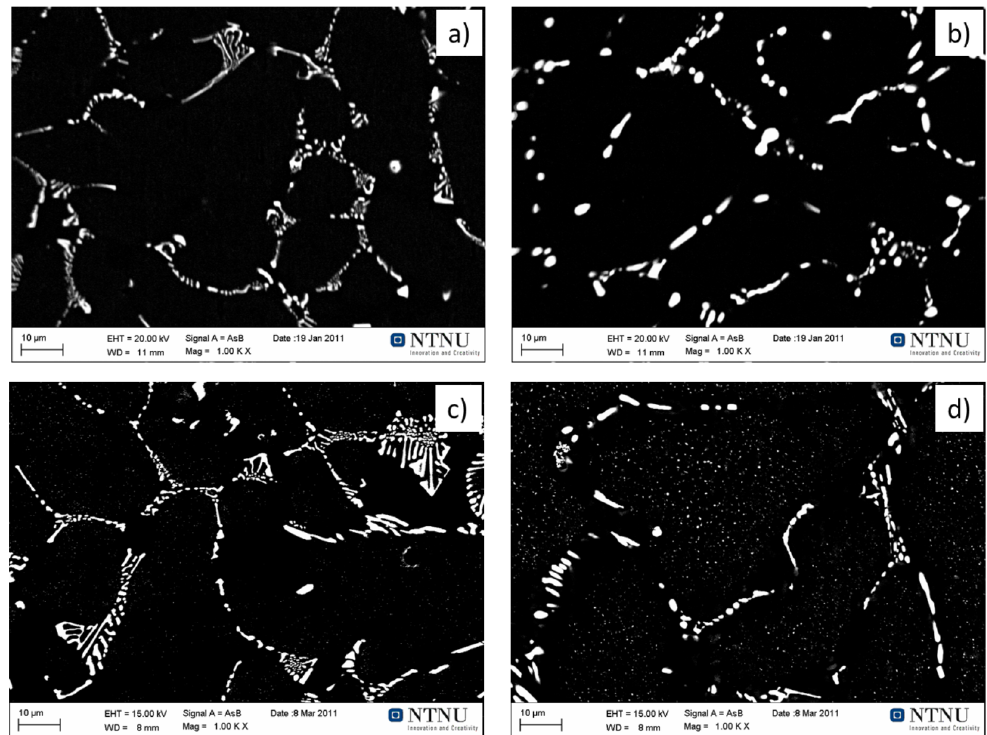
Figure 1. Back scatter electron scanning electron microscopy (SEM) images of constituent particles after the different homogenization procedures: ( a ) C2 ‐ 0 (non ‐ homogenized); ( b ) C2 ‐ 1; ( c ) C2 ‐ 2; and ( d ) C2 ‐ 3.